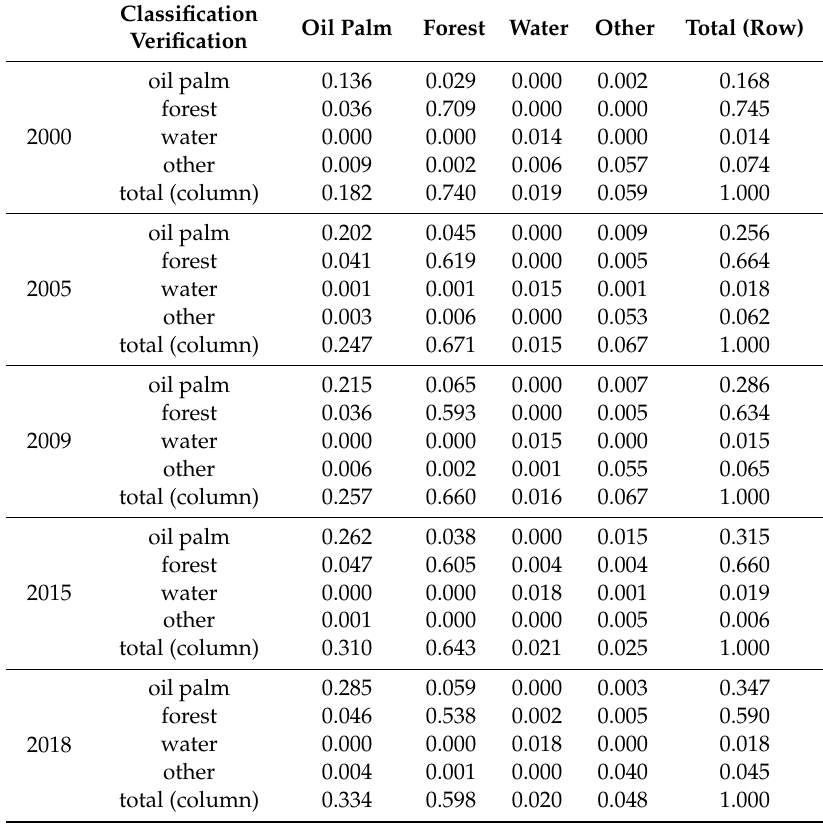
Table 2. The error matrix expressed in terms of the proportion of area used for the sample size and sample allocation planning calculations of 2000, 2005, 2009, 2015, and